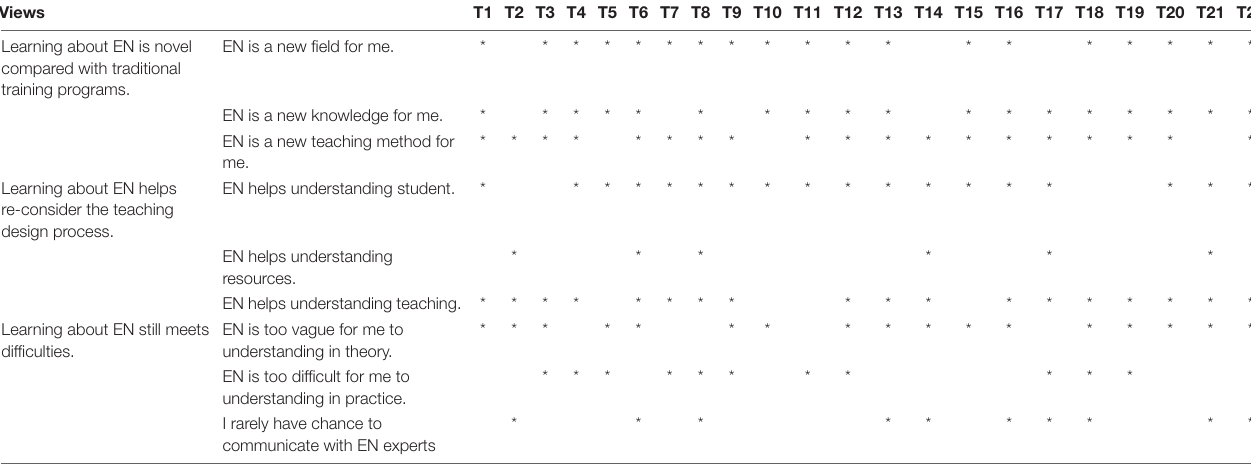
TABLE 5 | Views about learning EN in the teacher training program. Views Learning about EN is novel compared with traditional training programs.